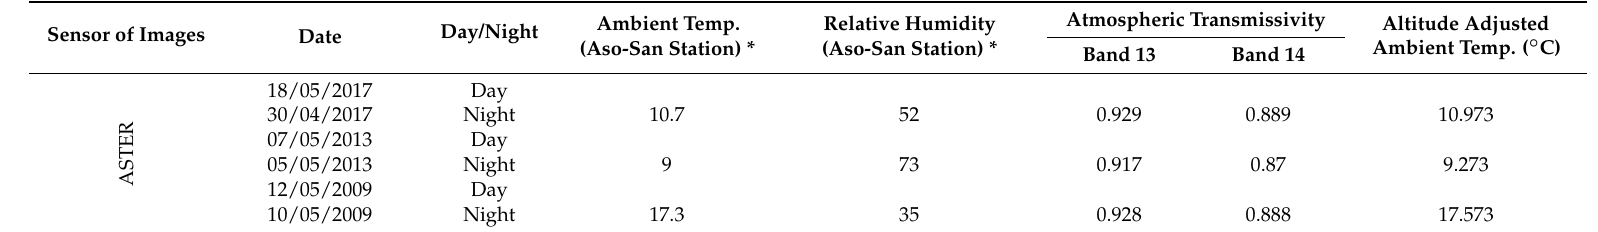
Table 1. Specifications for ASTER satellite images and local meteorological data from the Aso-san station for the study area. Sensor of Images